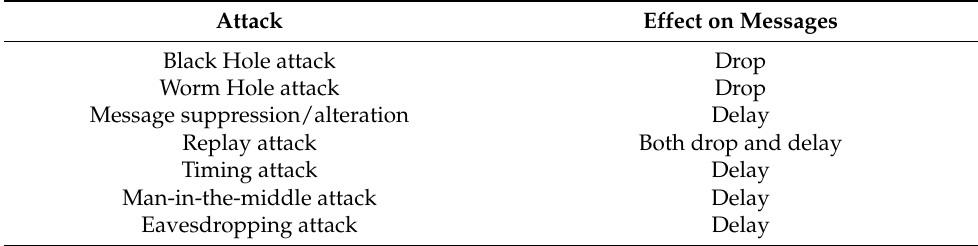
Table 1. Summary of attacks. Attack Effect on